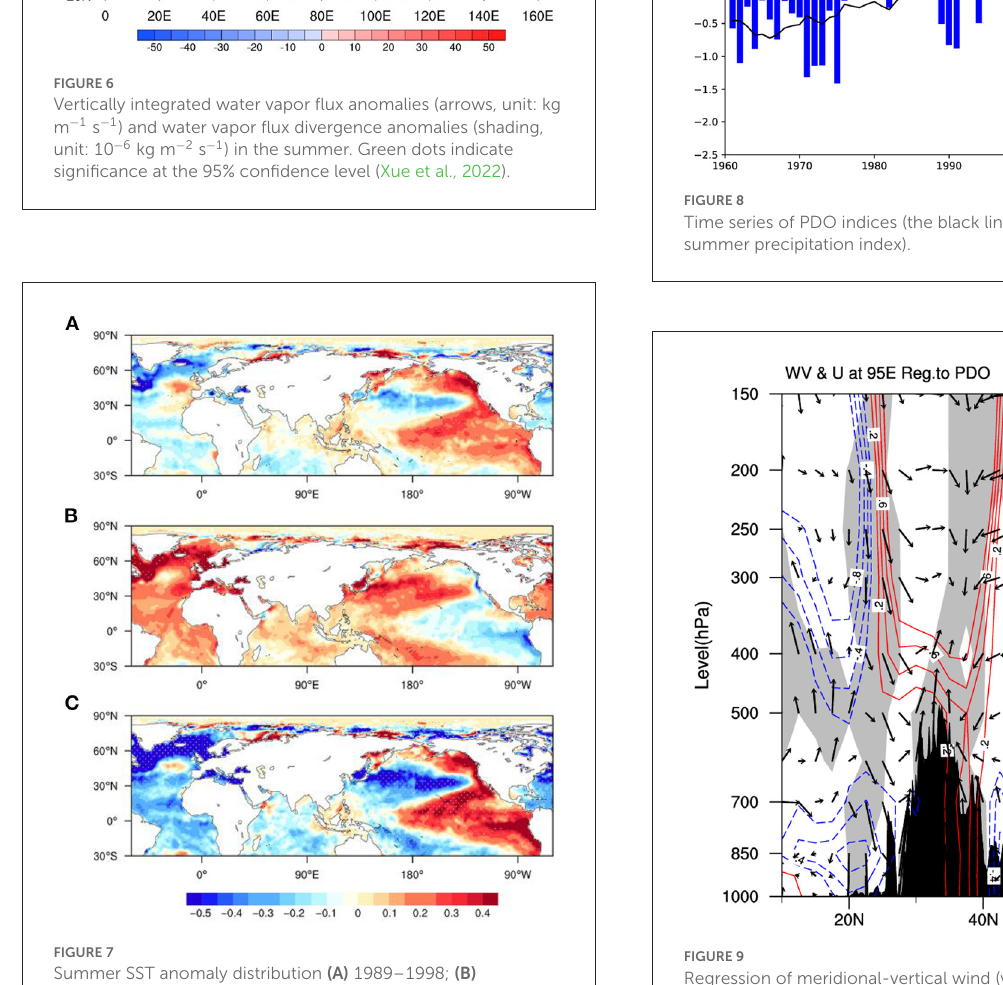
FIGURE9 Regression of meridional-vertical wind (vectors) and zonal wind (contours) along 95 ◦ E against the PDO index. Unit of vertical velocity ω is 0.2 × 10 − 2 Pa/s, and unit for zonal wind u and meridional wind v is m/s. Shaded areas denote significance at the 95% confidence